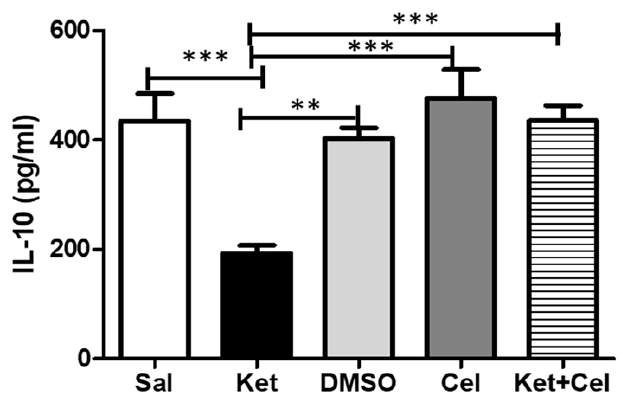
Figure 9. Celastrol administration in postnatal life prevented ketamine-induced IL-10 decrease in the cerebellum in later adulthood. IL-10 levels (pg / mL) in the cerebellum of adult mice receiving saline (Sal, n = 3) or ketamine (Ket, n = 5) or a 50% DMSO in PBS (DMSO, n = 3) or celastrol (Cel, n = 3) or ketamine + celastrol (Ket + Cel, n = 5) at PNDs 7, 9 and 11. One Way ANOVA, followed by Tukey’s post hoc test F = 15.19, *** p < 0.001, ** p < 0.01.